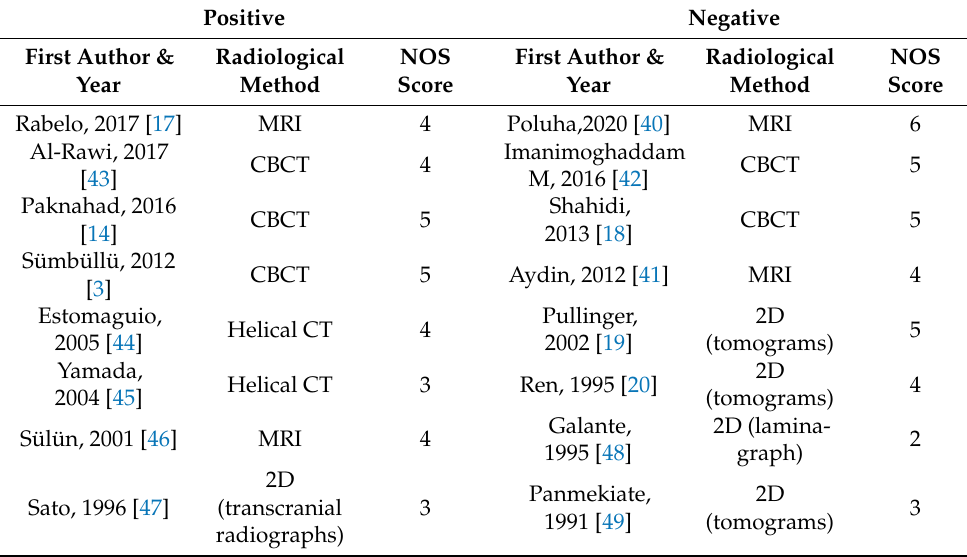
Table 6. Studies retrieved in full text and excluded from the